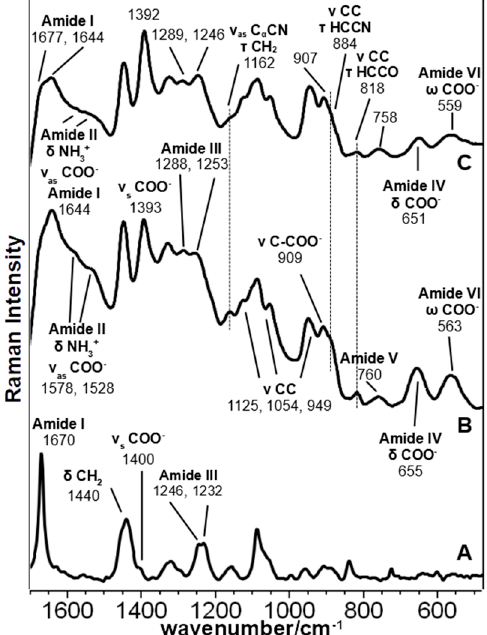
Figure 5. Comparison of the Raman spectrum (A) and SERS spectra of the parent peptide (Pept1) as-synthesized (B) and after irradiation (C).